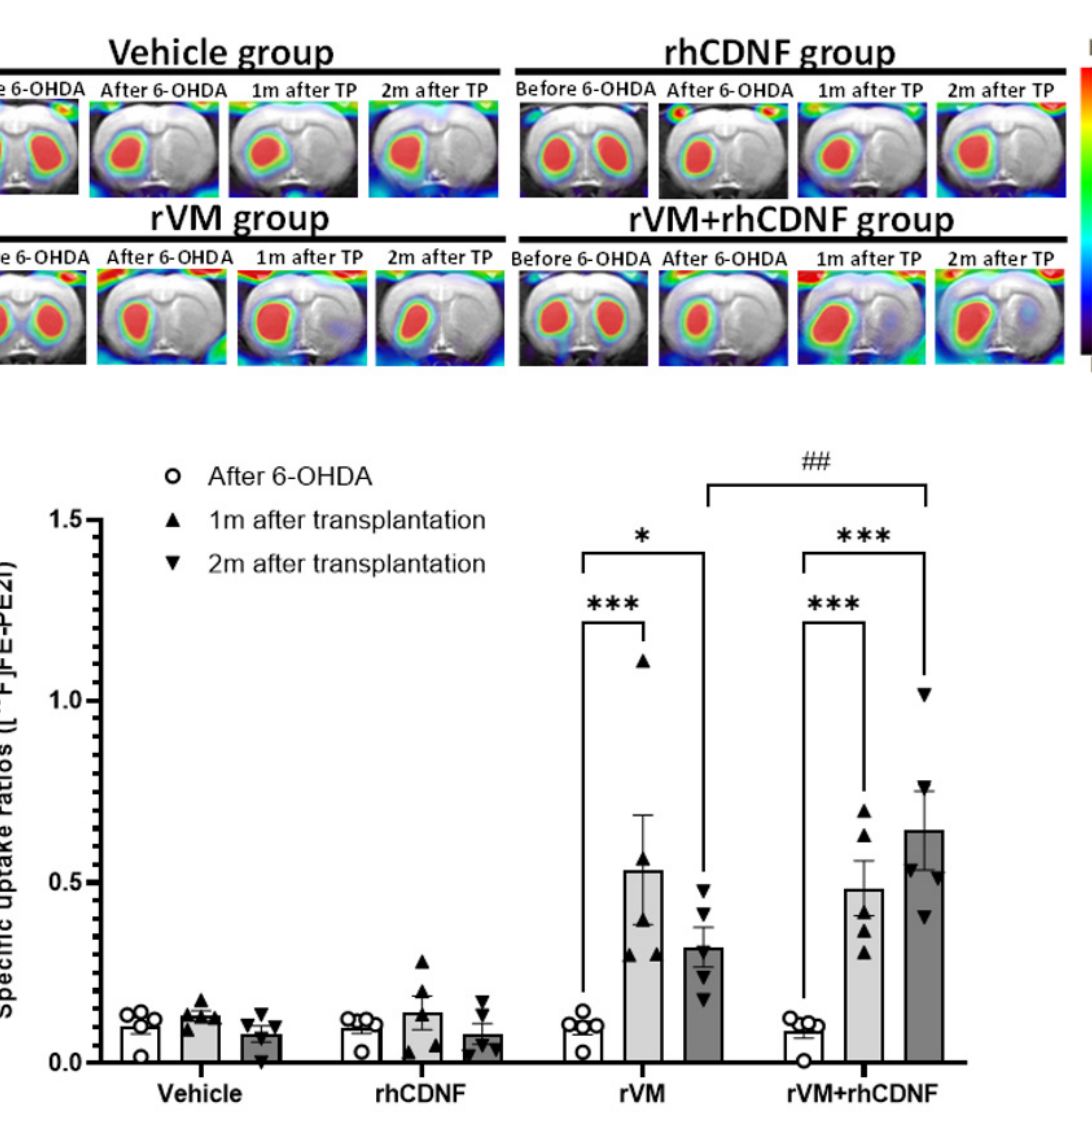
Figure 3. PET images of [ 18 F] FE − PE2I uptake distribution in rat brains. ( A ) Coronal (upper panel) and horizontal (lower panel) sections of each group were acquired 20–40 min after injection of 18 F- FE-PE2I. Left, middle, and right columns of each group represent 18 F-FE − PE2I uptake before the 6 − OHDA lesion, after the 6-OHDA lesion, and at 4 and 8 weeks after transplantation, respectively. ( B ) Specific uptake ratios (SURs) of 18 F − FE − PE2I of the grafted striatum at different time points and under differ therapeutic regimen. * p < 0.05, *** p < 0.001 by Tukey’s multiple comparisons test, following two-way ANOVA. ## p < 0.01 indicates comparison with the rVM + rhCDNF group with two-way ANOVA and Tukey’s post hoc test. The data represent mean ± SEM. 3.4. CDNF Enhances the Survival and Maturation of DA Neurons in the rVM Grafted Striatum To clarify whether the higher SURs of [ 18 F] DOPA attribute to more DA cells in the grafted tissue, we observed TH immunostaining of the lesioned striatum at 2 months after transplantation. In photomicrographs of brain sections of the vehicle and rhCDNF groups, TH-stained cells or fibers in the lesioned striatum were scarcely visible (Figure 4A,B). In contrast, TH-stained cell bodies and fiber were detectable in the striatum of rVM or rVM + rhCDNF transplantation groups (Figure 4C,D), while TH-stained cells or fibers were